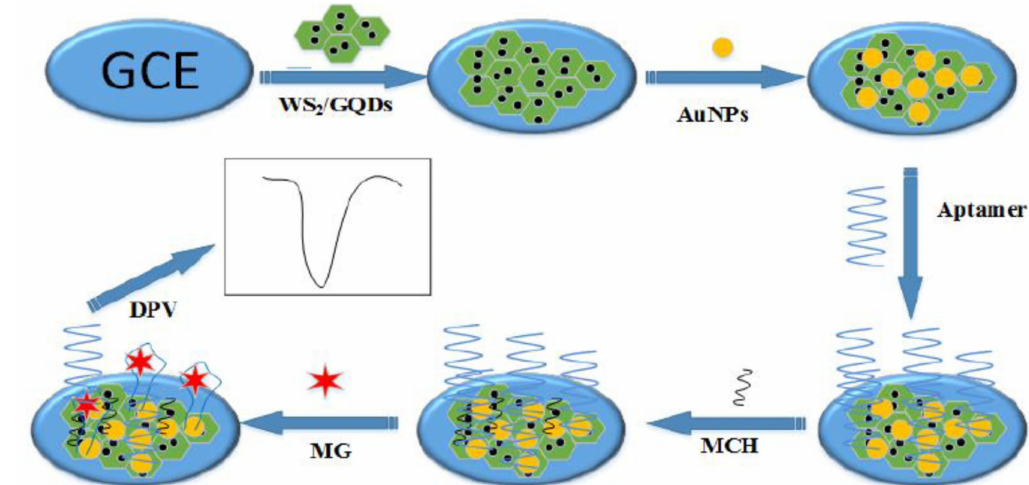
Figure 6. Working principle of a label free electrochemical aptasensor for the detection of malachite green. Reprinted from reference [31]. This article is an open access article distributed under the terms and conditions of the Creative Commons Attribution (CC BY) license (http://creativecommons.org/licenses/by/4.0/ 25 March